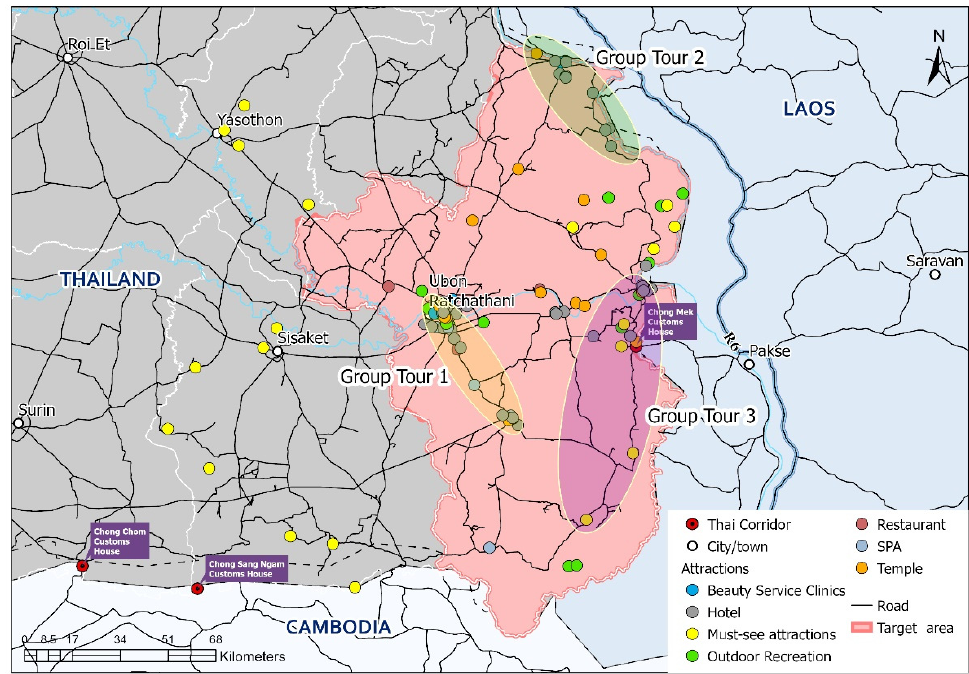
Figure 8. Demonstration of wellness tourist groups and attractions in the case